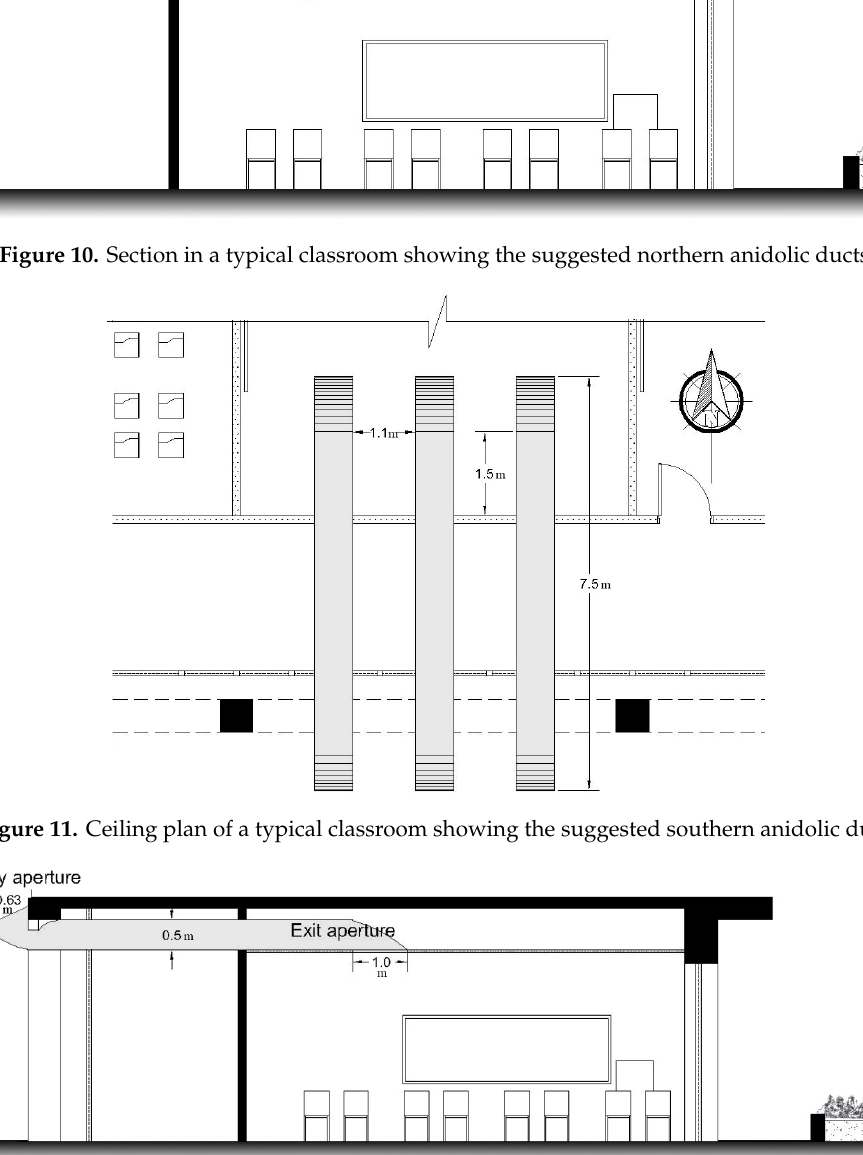
Figure 10. Section in a typical classroom showing the suggested northern anidolic ducts.